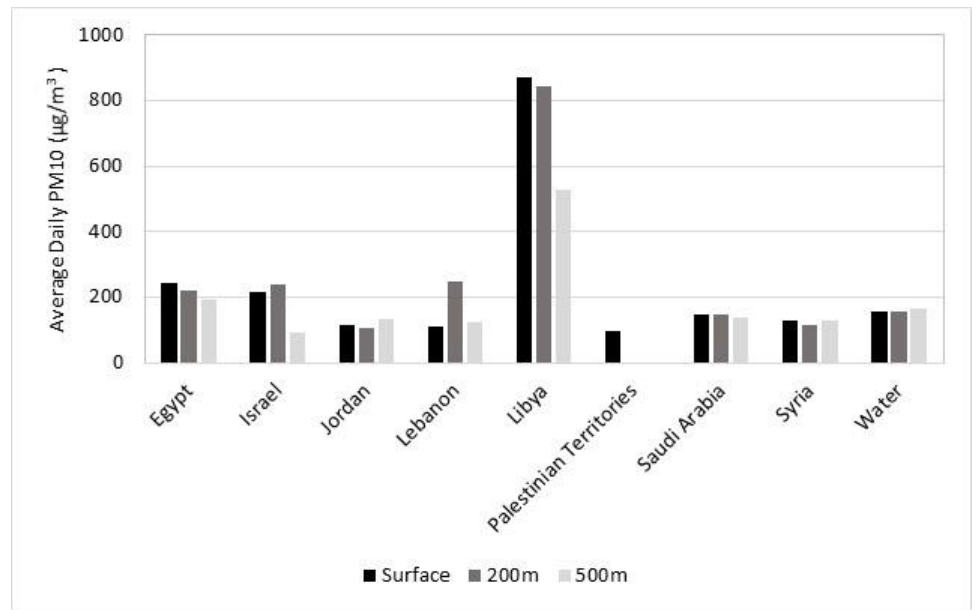
Figure 2. Average dust event PM 10 values in Be’er Sheva based on location of air 24 h prior to arrival in Be’er Sheva. Based on 24-h back trajectories at 0 m, 200 m, and 500 m. Minimum of 5 days.